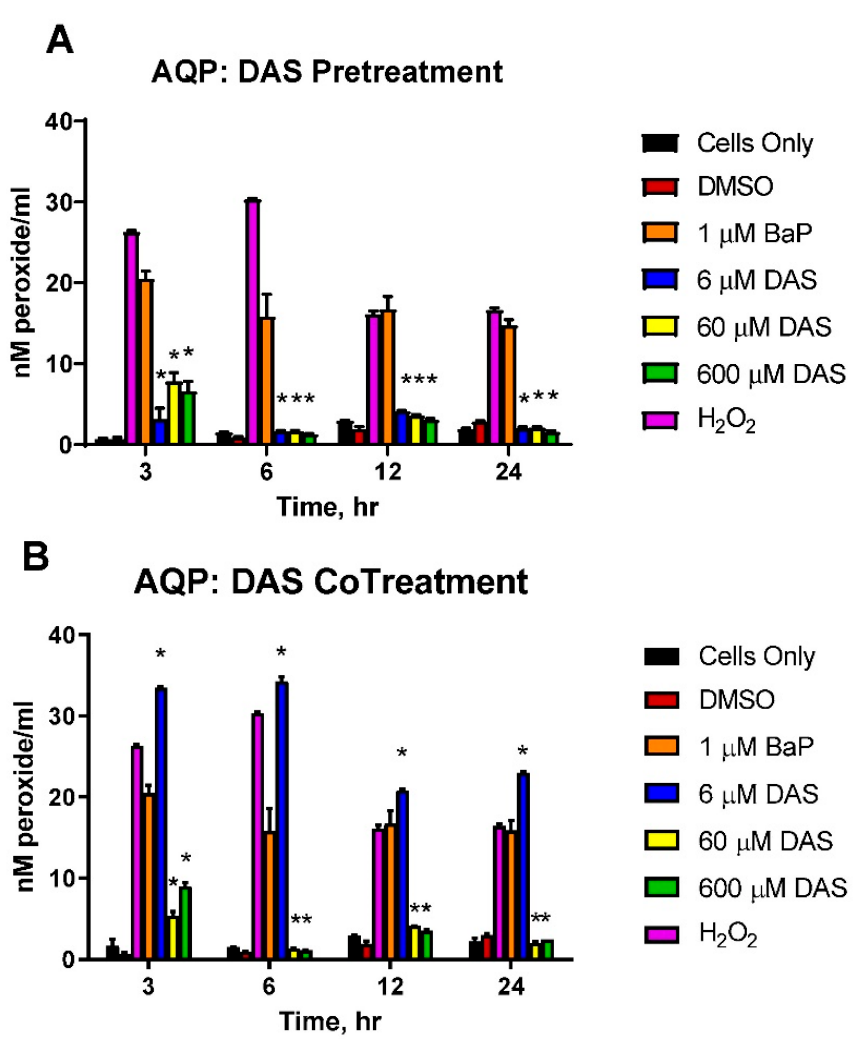
Figure 4. DAS inhibition of BaP-induced Aqueous Peroxides. The cells analyzed for Aqueous Peroxides were either pre-treated ( A ) with DAS followed by BaP or co-treated ( B ) with DAS and BaP for 3, 6, 12, and 24 h. The average values for replicates of N = 3 were compared to the cells pretreated ( A ) or co-treated ( B ) with DAS (6, 60, and 600 μ M) and BaP (1 μ M) (* indicates a p < 0.05 significant difference from DMSO control) in triplicate, +/ − SEM. As a positive control, 0.1% Hydrogen peroxide was used.